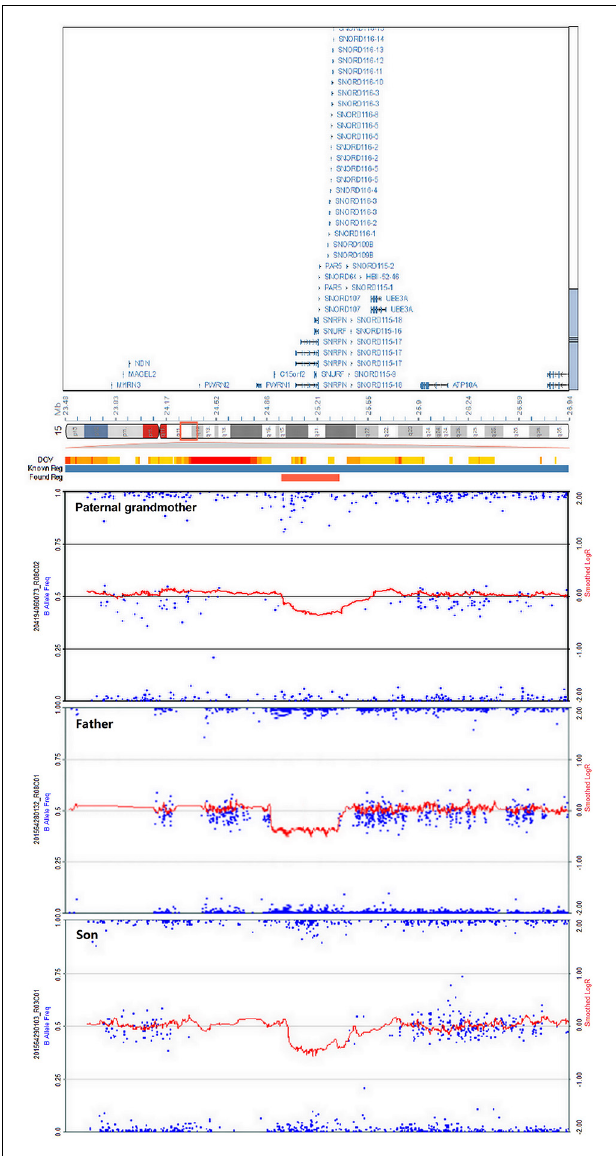
FIGURE 4 | Chromosome microarray analysis (CMA) demonstrating deletion of 15q11.2 in the paternal grandmother, the father, and the patient. The novel copy number variation (CNV) at the loci (chr15: 24,966,348–25,364,551) is of approximately 398 kb in heterozygous state, surrounding the SNRPN